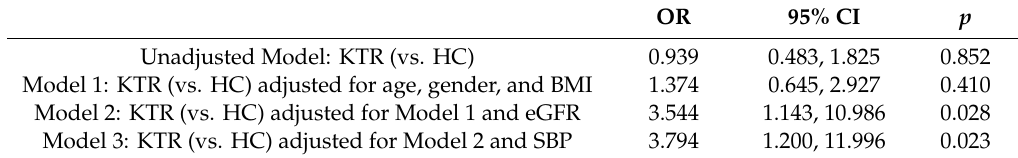
Table 3. Multiple logistic regression analysis for prevalence of glucose intolerance (glucose intolerance versus normal glucose tolerance) between kidney transplant recipients and healthy controls. OR 95% CI p Unadjusted Model: KTR (vs. HC)